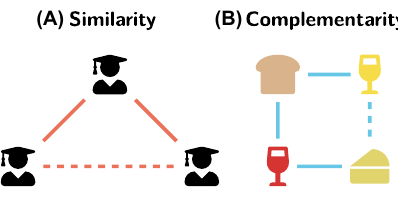
Figure 1. Intuitive meaning of similarity and complementarity. ( A ) If three persons are similar (e.g. they are all scientists) and we know that one of them (top) knows the other two (bottom) it is quite likely that they know each other too (dashed line). Thus, the relation is transitive . ( B ) If one wine (red) goes well with (is complementary to) bread and cheese and another wine (white) also goes well with the bread, then it is likely that it is a good match for the cheese too (dashed line). However, this does not imply that both wines will be drunk together, so the relation is not transitive